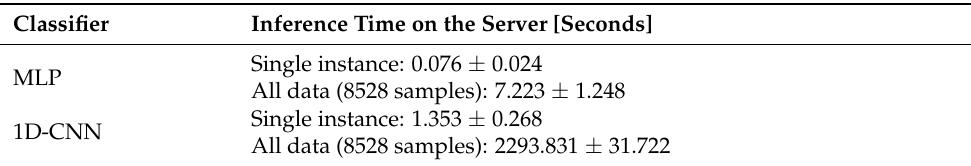
Table 4. Inference time of the proposed classifiers on MORE homomorphically encrypted